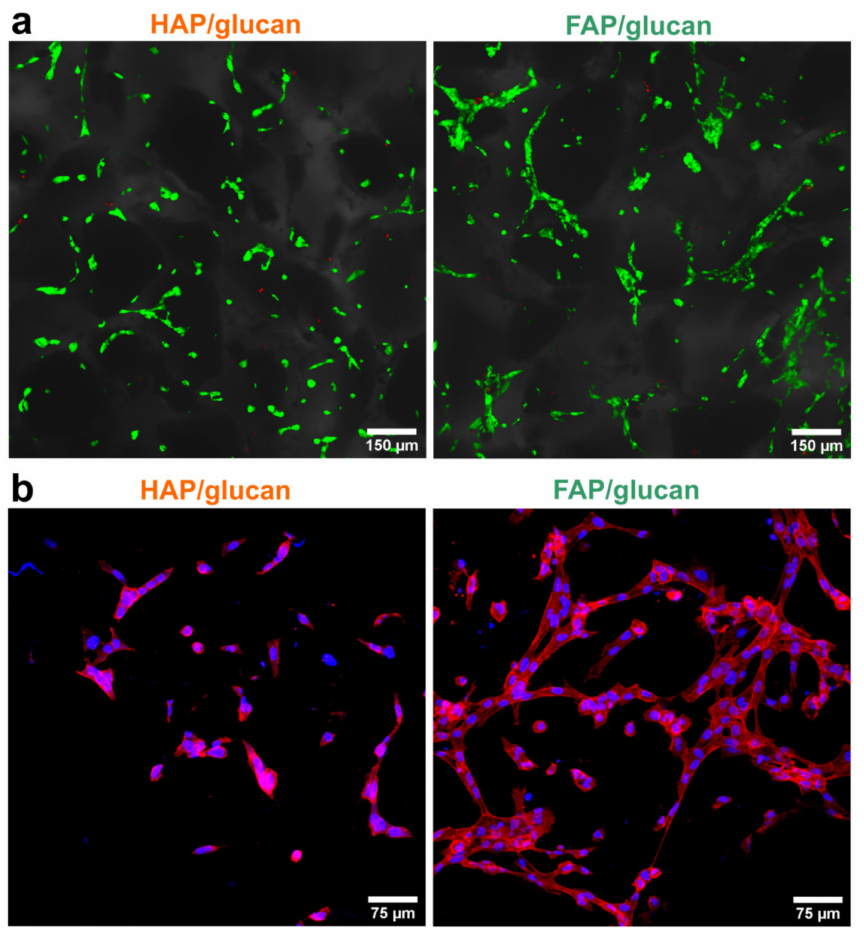
Figure 9. ( a ) Viability of cells in direct contact with the biomaterials visualized using confocal microscope (green fluorescence—viable cells, red fluorescence—dead cells, Nomarski contrast was used to visualize composite microstructure); ( b ) cell growth on the surface of the biomaterials visualized after fluorescent staining of cytoskeleton (red fluorescence) and nuclei (red